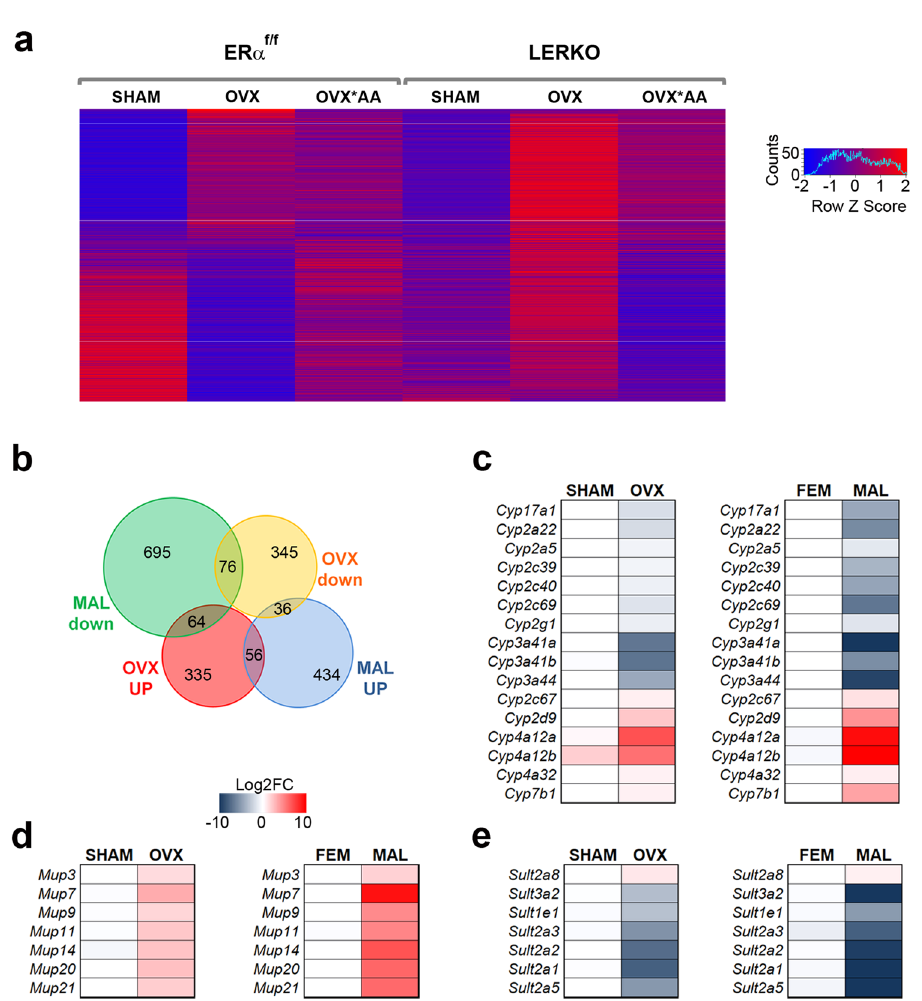
Fig. 5 Comparison of hepatic transcriptomes from different female genotypes and from males. a Heatmap showing overall the DEGs from RNA-Seq analysis ( n = 4) related to OVX and/or diet in ER α f/f and LERKO females. b Venn diagram summarizing the overlap between DEGs identi fi ed by RNA-Seq ( n = 4) in the liver of male, fertile female and OVX female ER α f/f mice. c – e Heatmaps reporting as Log 2 FC the mean expression ( n = 4) of the most enriched class of genes differentially expressed in the livers of OVX ER α f/f females and in the livers of ER α f/f males with respect to fertile ER α f/f females. Source data are provided in 56 ; processed data are provided as a Source Data fi